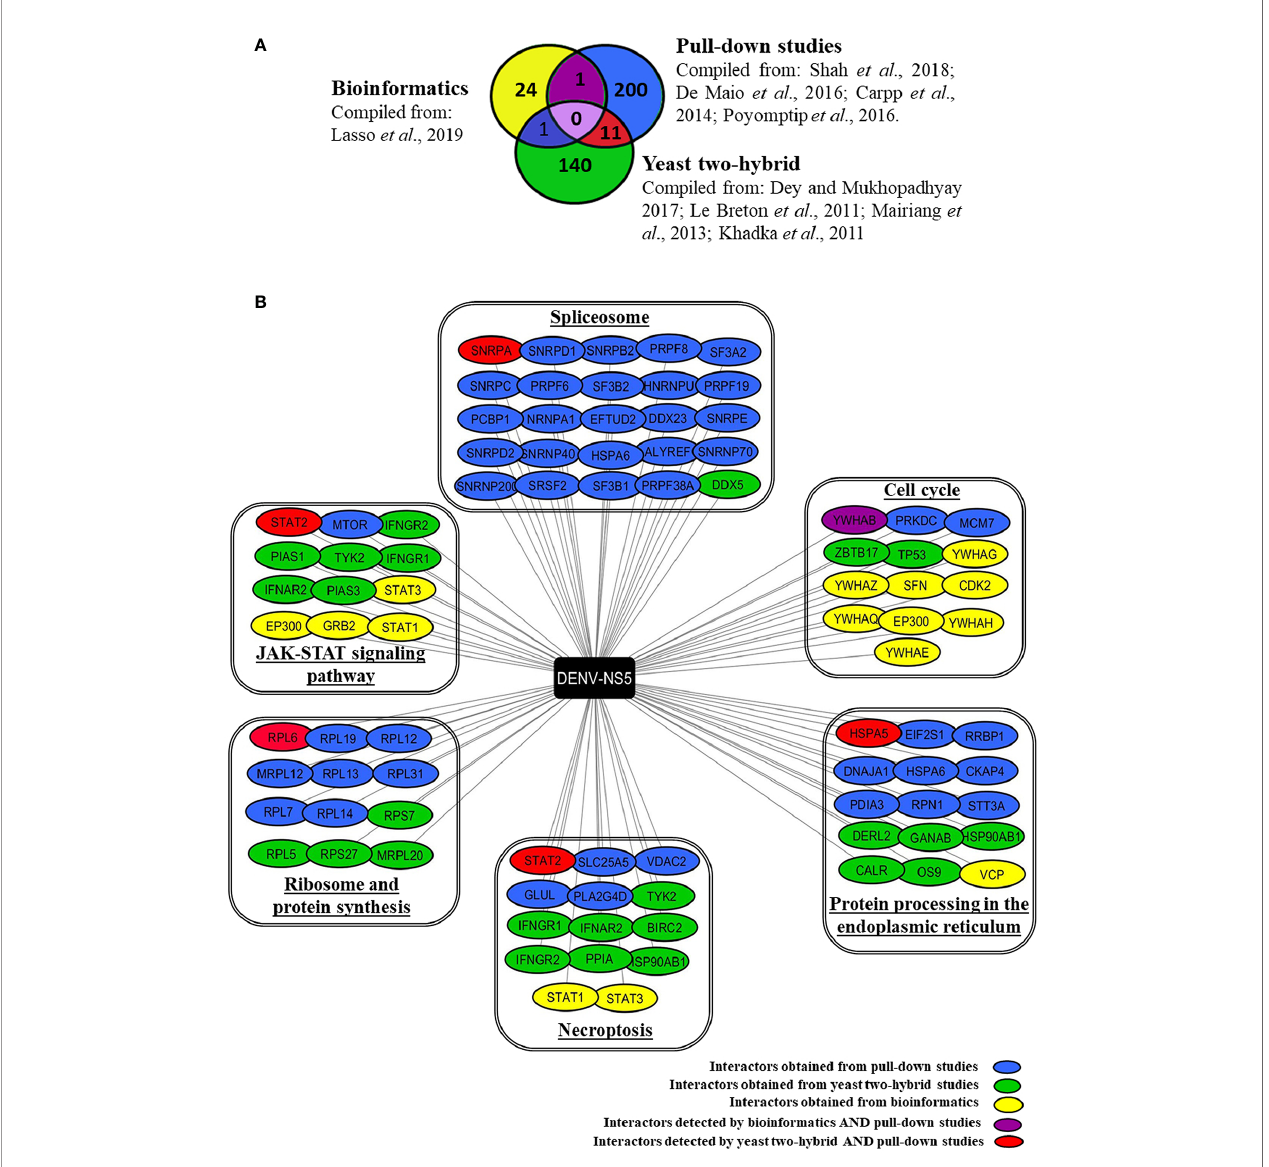
FIGURE 1 | Human interacting partners of DENV-NS5 curated from various experimental studies and databases. (A) The Venn diagram indicates the number of DENV-NS5 interacting proteins that are shared with and/or unique to PPI studies in the literature viz., yeast-two-hybrid studies, pull-down studies, and bioinformatics. Yeast-two-hybrid data were curated from the DenvInt database, bioinformatics-based data was obtained from P-HIPSTer, and pull-down data has been derived from published data sources. All cited sources and extended data are compiled and listed in Supplementary Table 1 . (B) Some of the NS5 interactors involvement in key KEGG pathways as obtained using the WEB-based GEne SeT AnaLysis Toolkit. The interactors are grouped in boxes based on the key pathways that they are involved in as obtained from KEGG. The proteins are color-coded according to the method used for their identi fi cation. A list of all signi fi cant pathways with a false discovery rate (FDR) < 0.05 is given in Supplementary Table 2 . The complete results of the GO fi ltering are shown in Supplementary Figure 1 . SPTAN1 is the only protein detected by both bioinformatics and yeast two-hybrid experiments but has not been shown here because it was associated with a false discovery rate > 0.05 which is the threshold for our